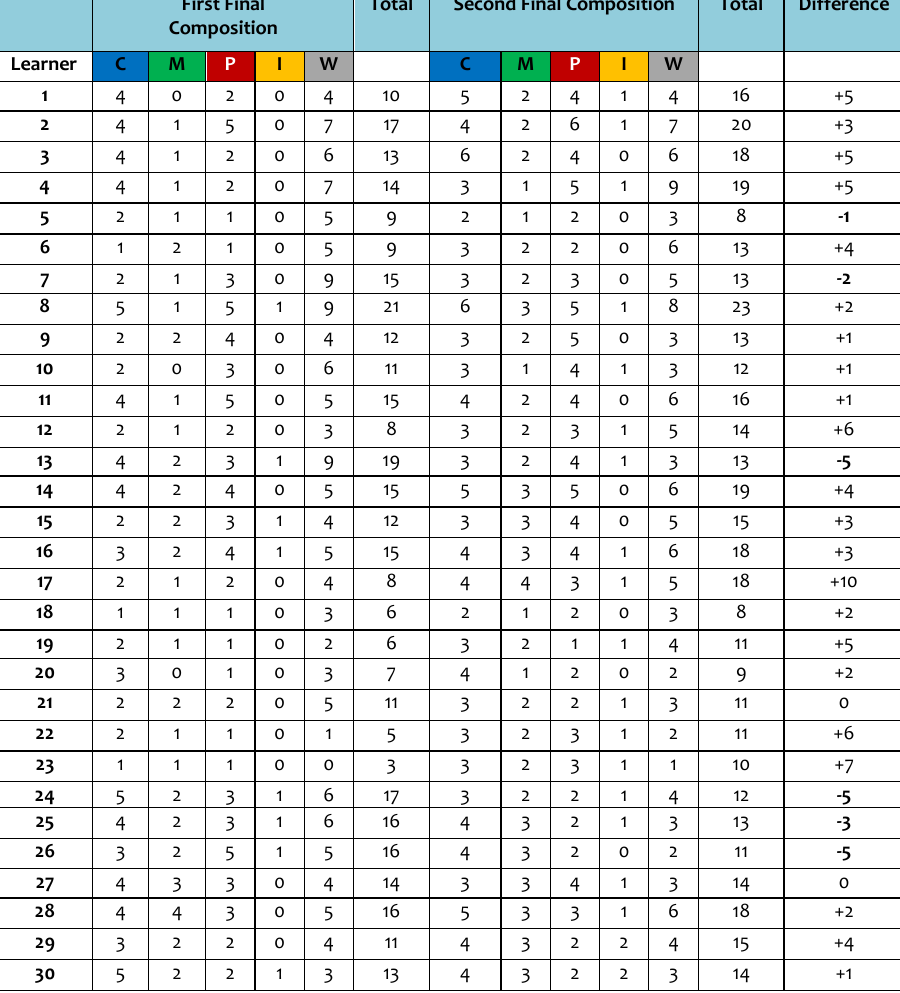
Table 7. Number of Lexical Units Used in Compositions 1 and